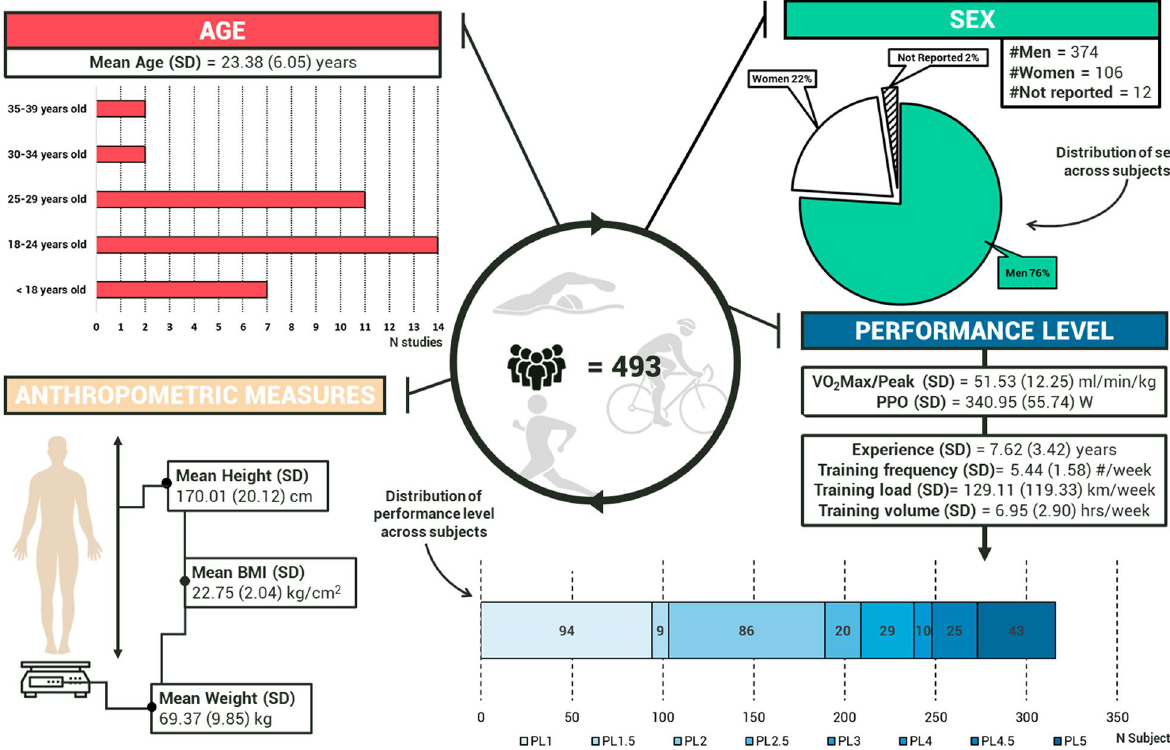
Fig. 2 Schematic overview of the included individual features of the selected studies ( PL performance level; Icons courtesy of the Noun Project. com (artists: Adrien Cocquet, Guilherme Silva Soares, Aleksandr Vector,